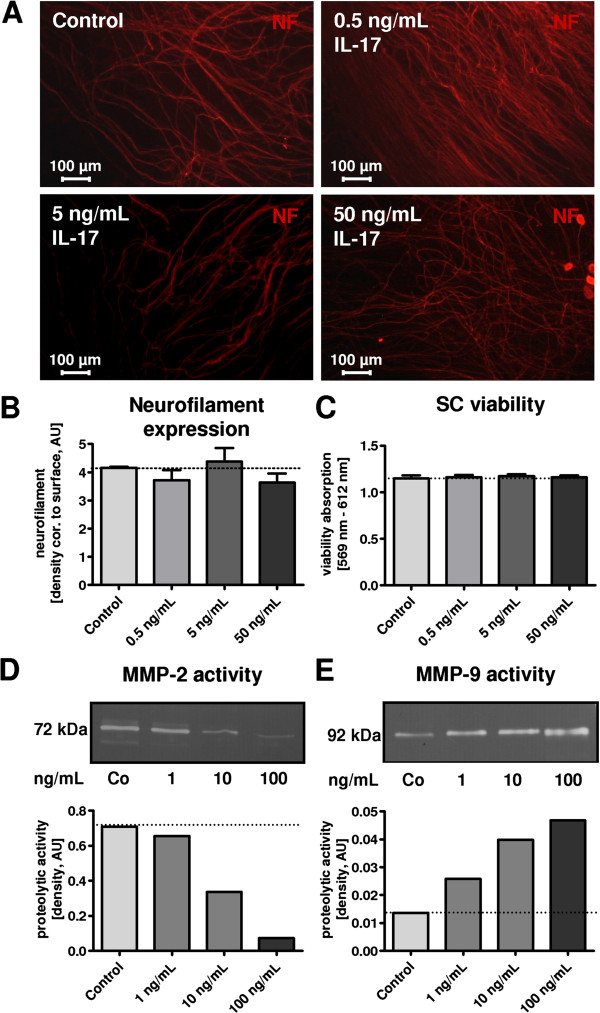
Neuronal outgrowth, Schwann cell (SC) viability, and Matrix metalloproteinases (MMP) activity in Interleukin 17 (IL-17) treated cultures. (A) Neuronal outgrowth was assessed in mouse dorsal root ganglia (DRG) co-cultures after exposure for 21 days to IL-17 at the indicated concentrations. Representative neurofilament (NF)-stained images of the cultures are depicted. (B) Quantification of NF, using densitometry analysis, normalized to background fluorescence and control stimulation. Analysis did not reveal a significant alteration in neuronal outgrowth. (C) SC viability was analyzed after IL-17 stimulation for 7 days at the indicated concentrations. Concentrations between 0.5 and 50 ng/mL did not significantly alter SC viability. Graph for viability and neurofilament analysis shows results of three independent experiments (D, E). MMP activity in IL-17-treated DRG co-culture supernatants was analyzed using gelatine zymography and quantified densitometrically. Representative zymography with the densitometry analysis is depicted. Overall, three independent experiments were performed and analyzed, exhibiting comparable results. AU, arbitrary unit. IL-17 led to a dose-dependent increase in inflammatory MMP-9 activity (E; 92 kDa), whereas the active and the inactive form of MMP-2 (D; MMP-2 inactive: 72 kDa, active: 62 kDa) decreased in activity.